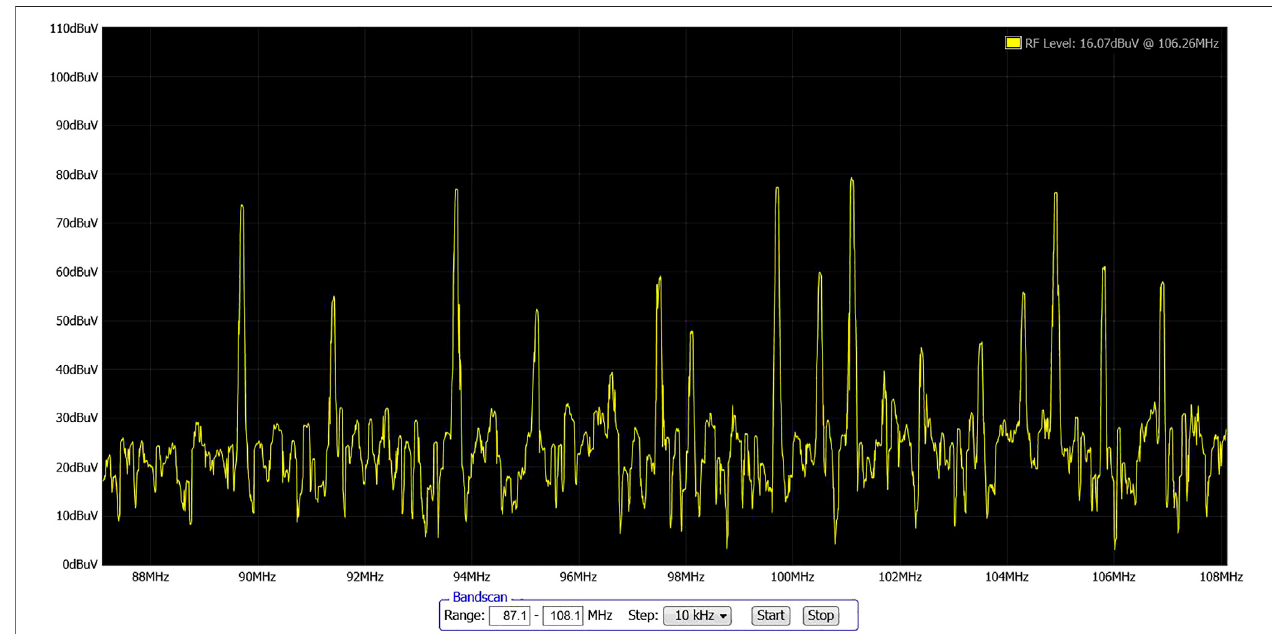
FIGURE2| Amplitude diagram offull-band FM signals,whichcancover theentire FMbandwidth from88to108 MHz. Then, thestronger the signal,thebetter the stability, so the frequency band with a larger amplitude is selected as a collection channel.